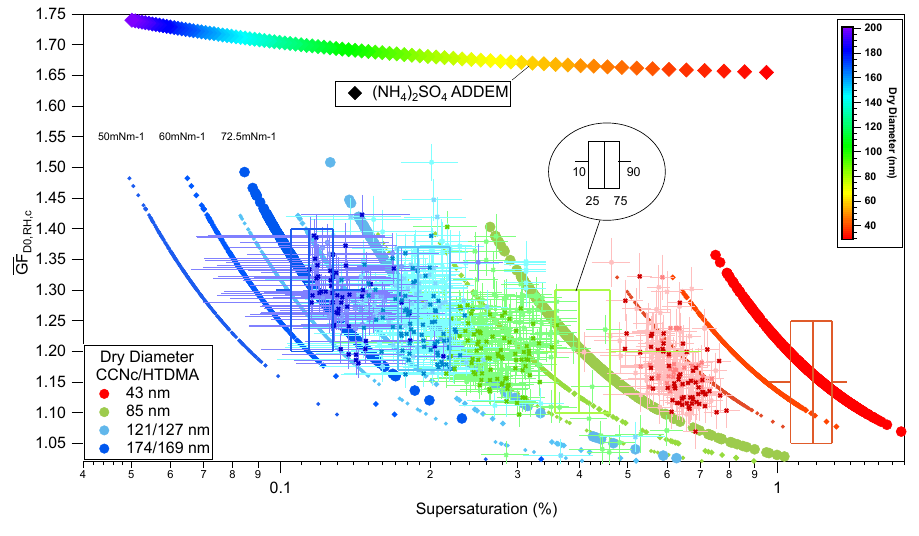
Fig. 4. GF D plotted against derived critical supersaturation for HTDMA dry diameters 43nm ≤ D 0 ≤ 169nm. The crosses repre- 0 , RH , c sent measured data and the circles of increasing diameter represent predictions from the model with three surface tensions; 50mNm − 1 , 60mNm − 1 and 72.5mNm − 1 respectively. Error bars are shown in both axis representing the uncertainty in the measured growth factor, and derived S c ,D . 0